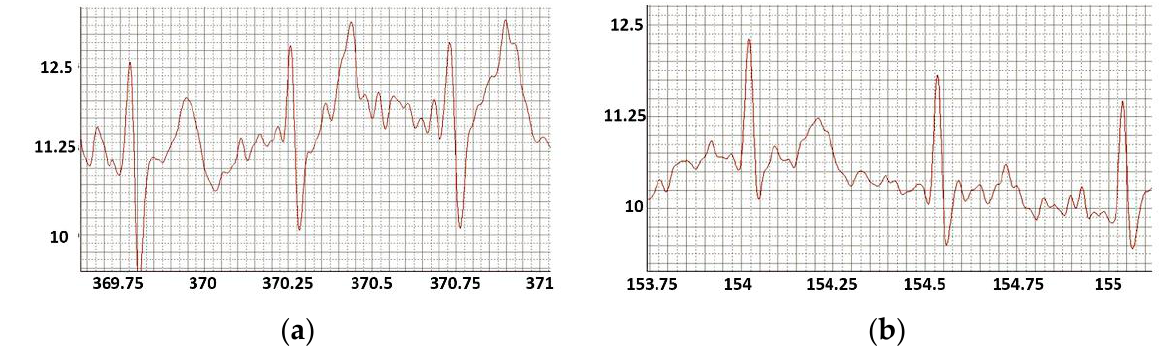
Figure 7. The ECG of the long-distance runner ( a ) and sprinter ( b ) during the exercise load. However, after the load (Figure 7), there were a number of noticeable differences, recorded by the “traditional” physiology: the differences in heart rate were significant, the reduction in the intervals for both test people occurred due to diastole, the ECG of both athletes had ST elevations, but of different magnitude. Also, both athlete ECGs had distortions of the isoline. However, in addition, we noticed that the long-distance runner had a redistribution of negative and positive ECG impulses, while the sprinter did not. Exercise physiologists with their traditional equipment, an exercise bike with a “Schiller” monitor, did not pay attention to this “adaptation” of the cardiovascular system to loads [7,14–16]. New studies, made possible by the ECG recorders offered in the article, should answer the question whether distortion of the ECG isoline provides additional information about an athlete’s overstrain.